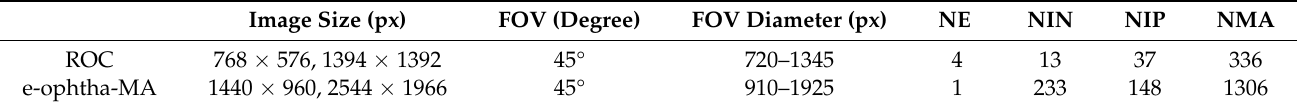
Table 1. Dataset